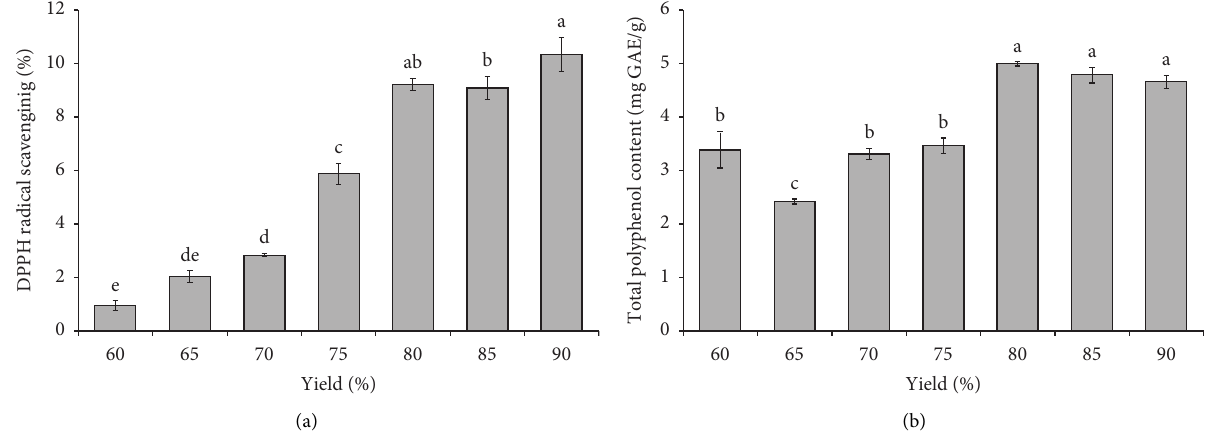
Figure 1: DPPH radical scavenging activity (a) and total polyphenol content (b) of wheat flour (var. Jokyoung) based on yield. Error bars represents standard deviations. Different characters within each graph are significantly different across the samples at p < 0 . 05 by Fisher’s least significant difference